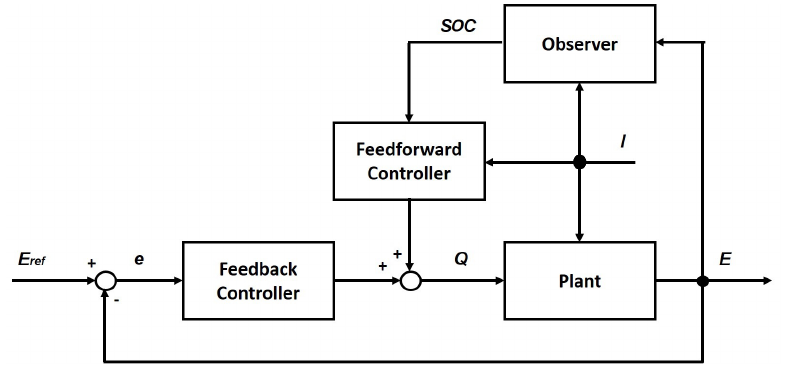
Figure 5. Conventional controller block scheme in a